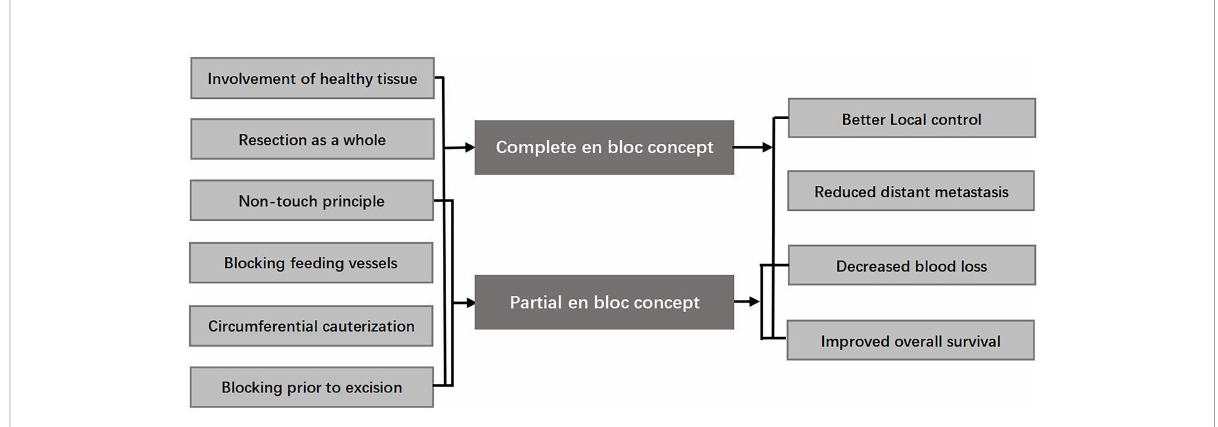
FIGURE 1 Complete and partial en bloc concept involved in this study and their hypothetical